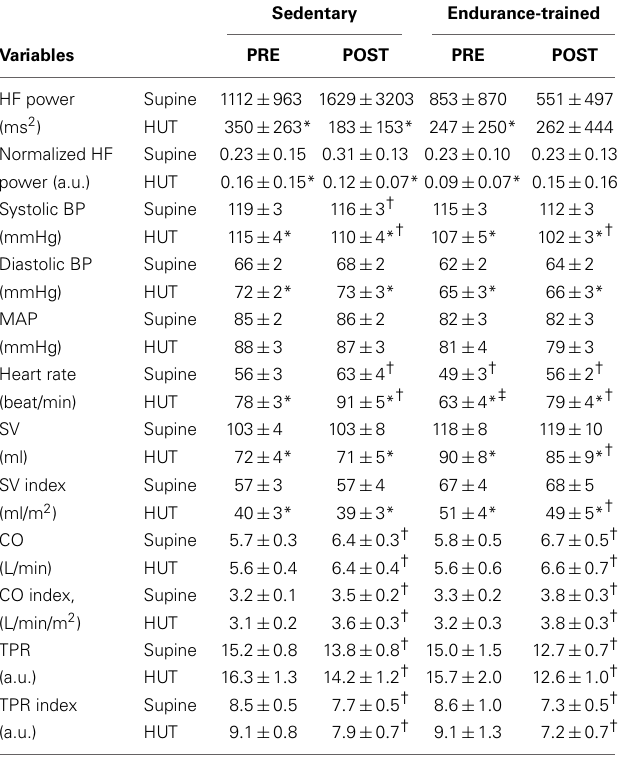
Table 2 | Pre- and post-exercise heart rate variability and hemodynamic changes with 5-min head-up tilt (HUT). Sedentary Endurance-trained